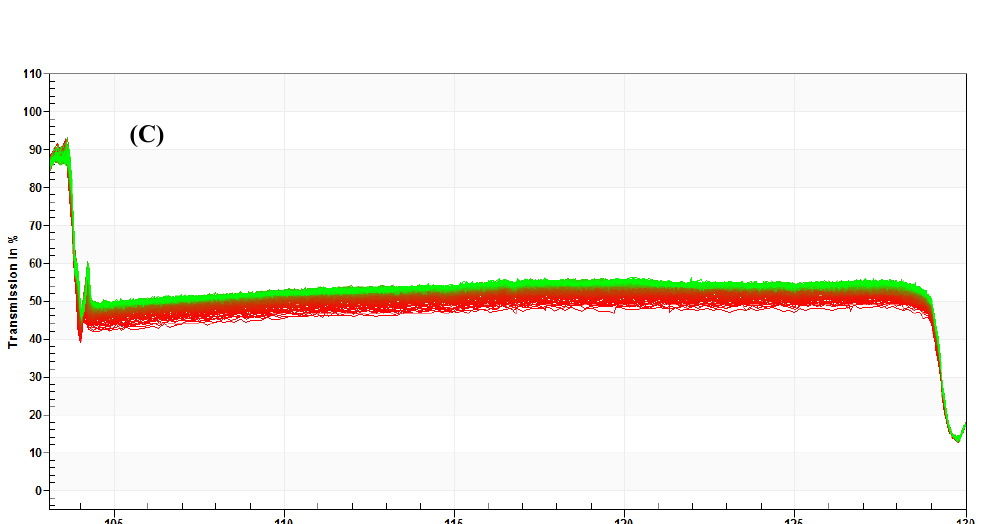
Table 1. Instability index of HA-based nanoemulsion containing P. pubescens oil at temperatures of 5, 30, and 40 °C.